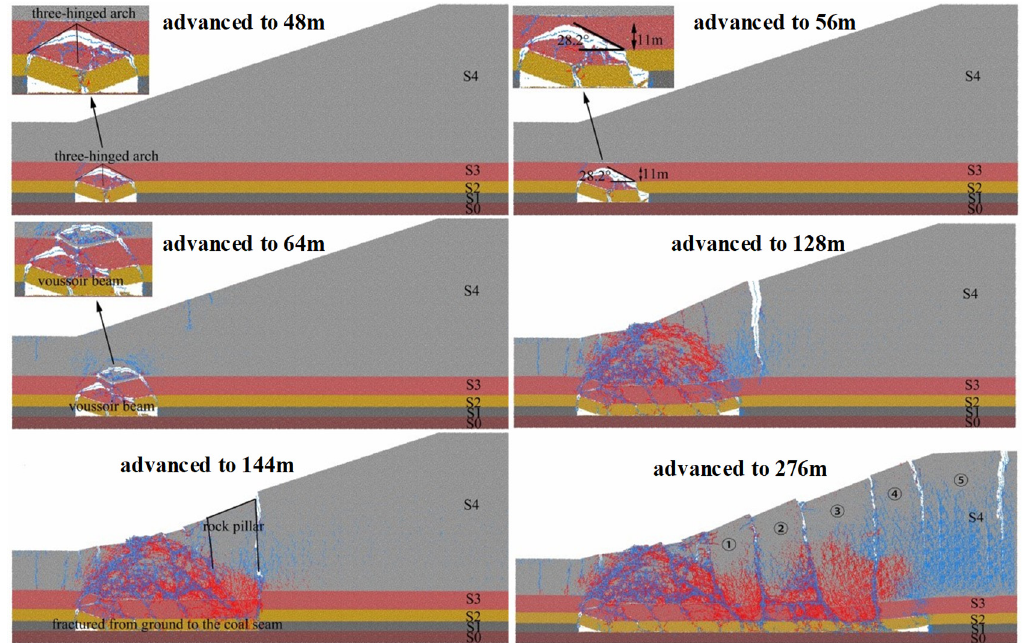
Figure 13. Evolution of collapse of overlying strata during the advance of the working face.